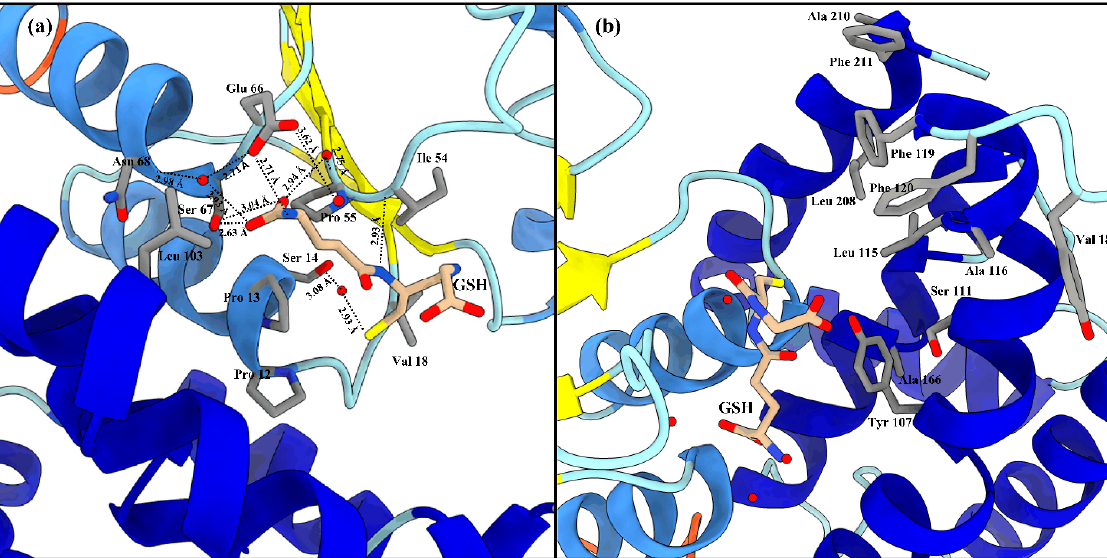
Figure 4. LdGSTu1 active site with GSH. ( a ) Zoomed in view with substrate GSH bound to LdGSTu1 active site. An extensive hydrogen bonding network was established between LdGSTu1, crystallographic water molecules and the GSH substrate. Hydrogen bond lengths between LdGSTu1 residues, waters, and GSH are shown with dashed lines and given bond lengths are given in angstrom; ( b ) Adjacent to the bound GSH, is the H-site located on the C-term domain side of the active site, side chains of the amino acids making the presumptive hydrophobic substrate binding site are shown in elemental color scheme.